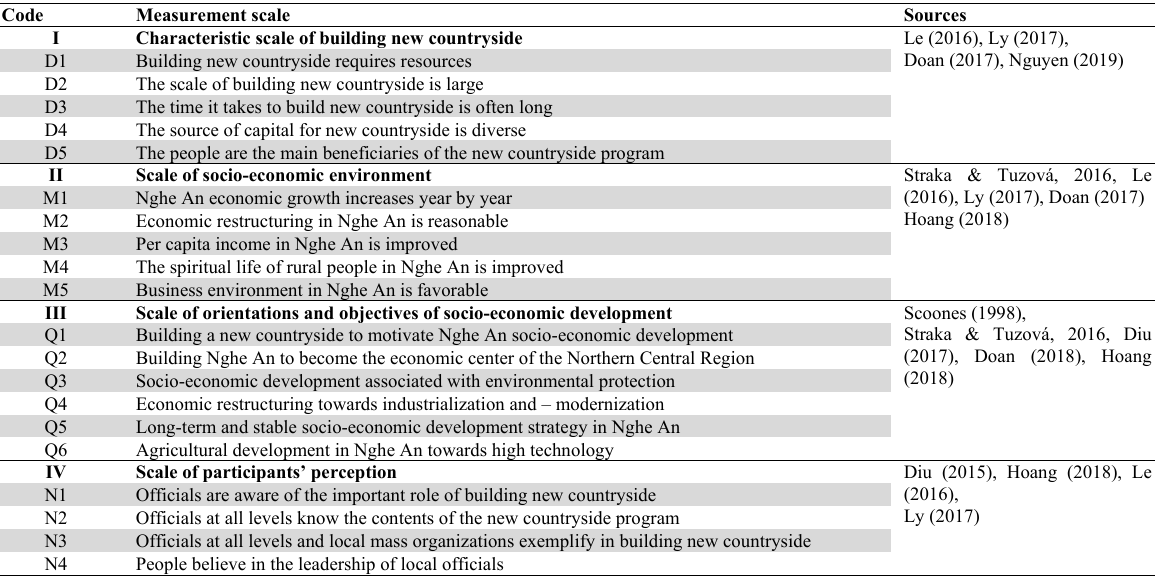
The scales in the research model